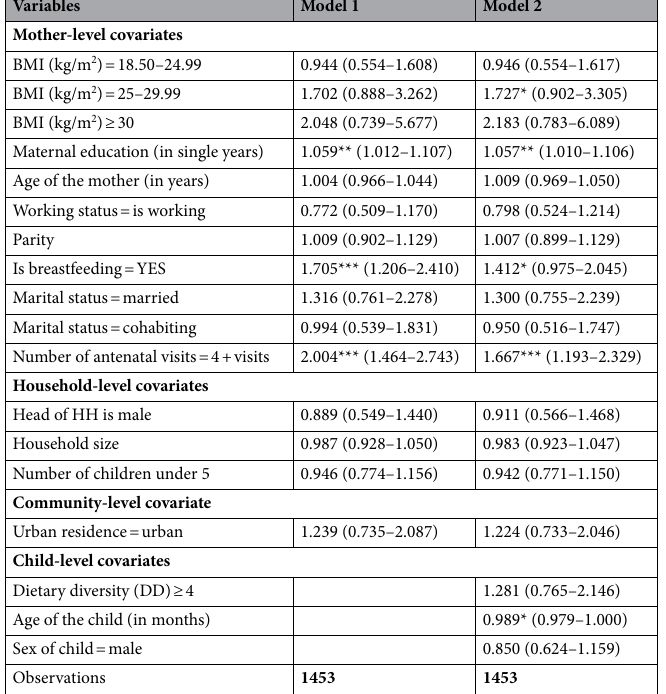
Table 3. Multivariable analysis of the effects of socio-demographic factors on better linear growth/non- stunting among children living in poor households in Ghana. Significant values are in bold. 95% confidence intervals (CIs) in parentheses. DD dietary diversity, HH household, BMI body mass index. *** p < 0.01, ** p < 0.05, * p <